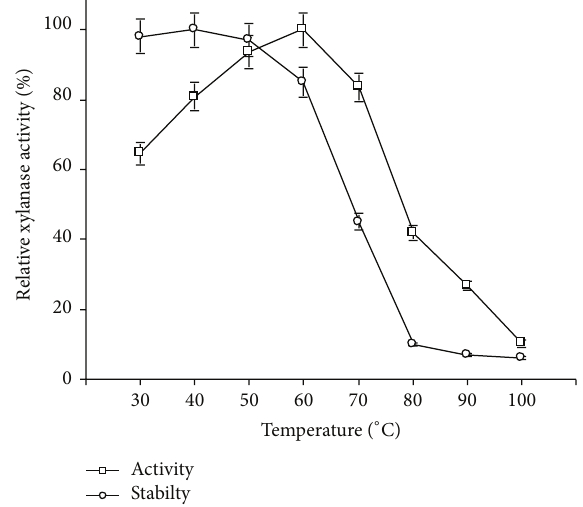
Figure 6: Effect of temperature on activity and stability of crude xylanase preparation of strain X1.